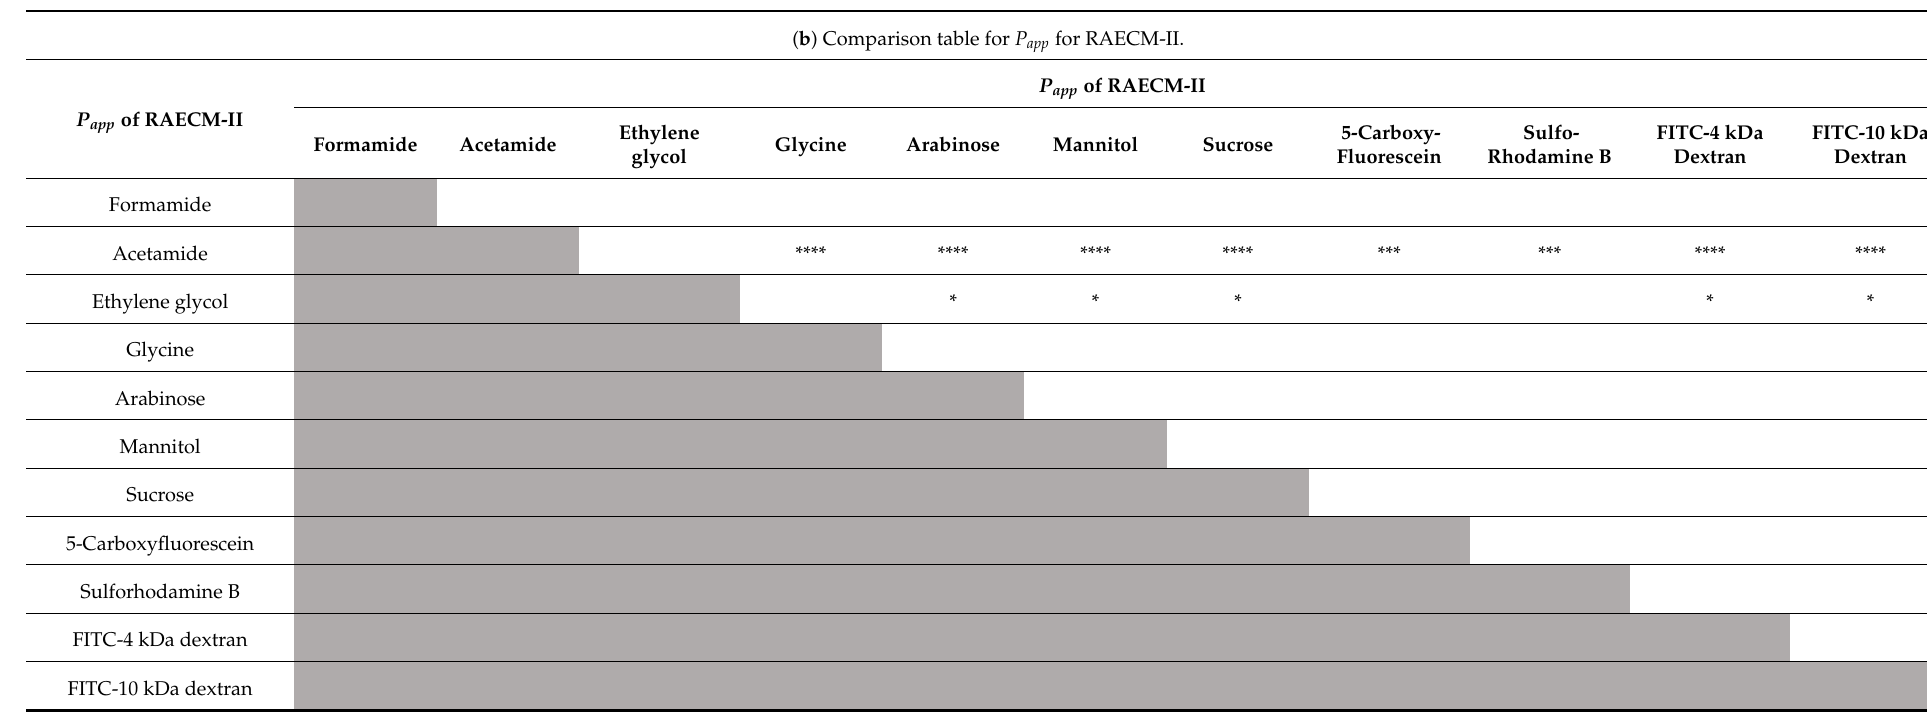
Table A1. Cont. ( b ) Comparison table for P app for